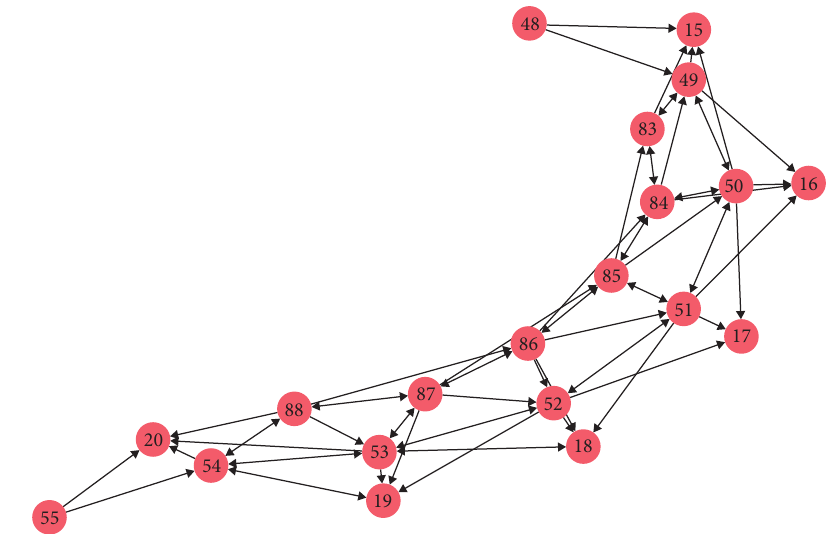
Figure 10: Diagram of a directed weighted network in the transition